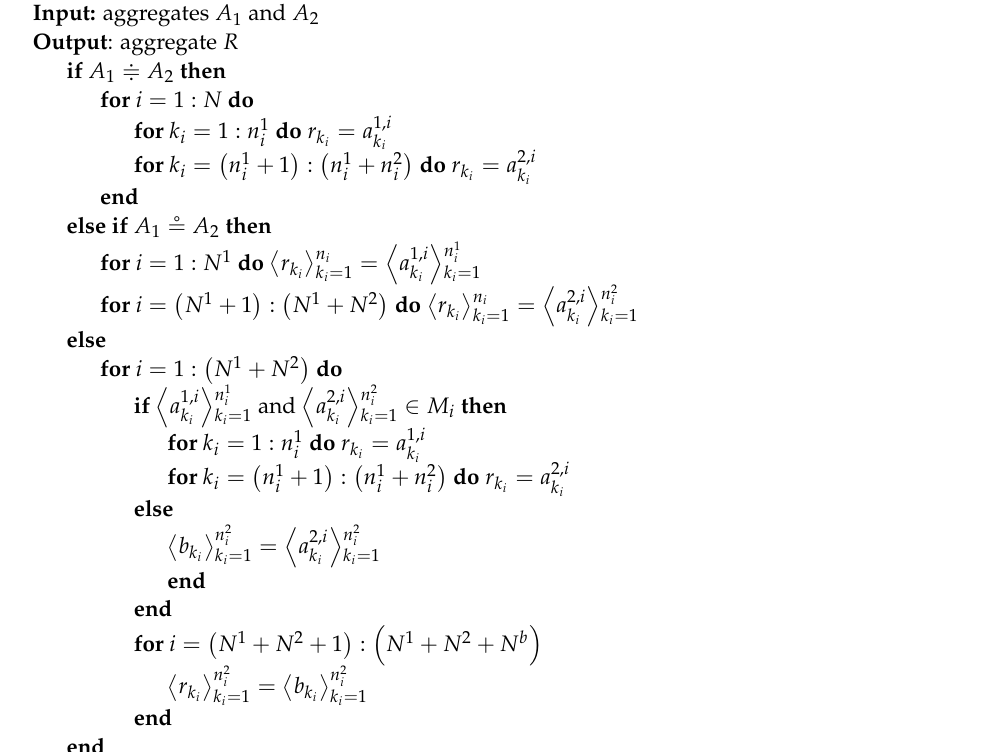
( b ) The results of the intersection operation. Figure 6. An example of applying the intersection operation to two compatible aggregates. Figure 6. An example of applying the intersection operation to two compatible